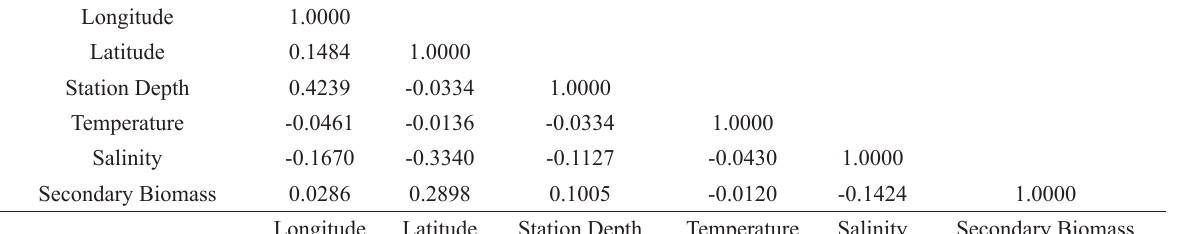
Weighted correlation matrix from CCA.